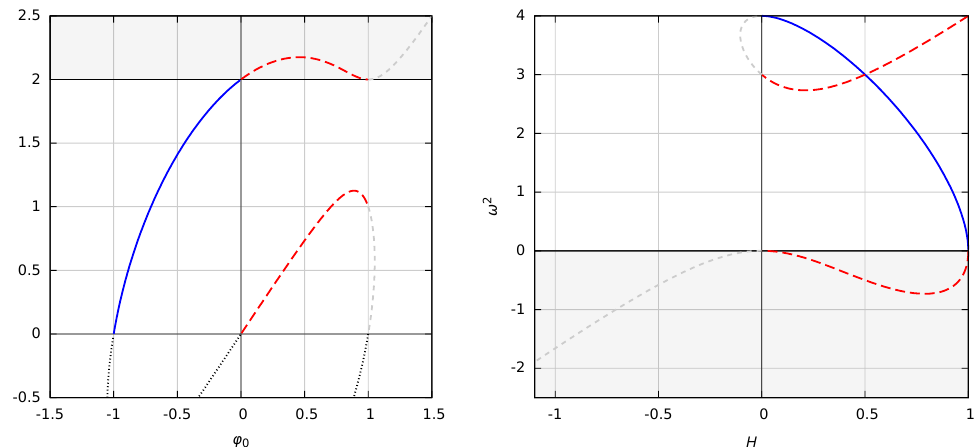
Figure 5 . Linearised boundary mode analysis: on the left, the solutions of equation (5.2) as a function of (cid:30) 0 = (cid:30) (0); on the right, the frequencies of localised boundary modes as a function of H .